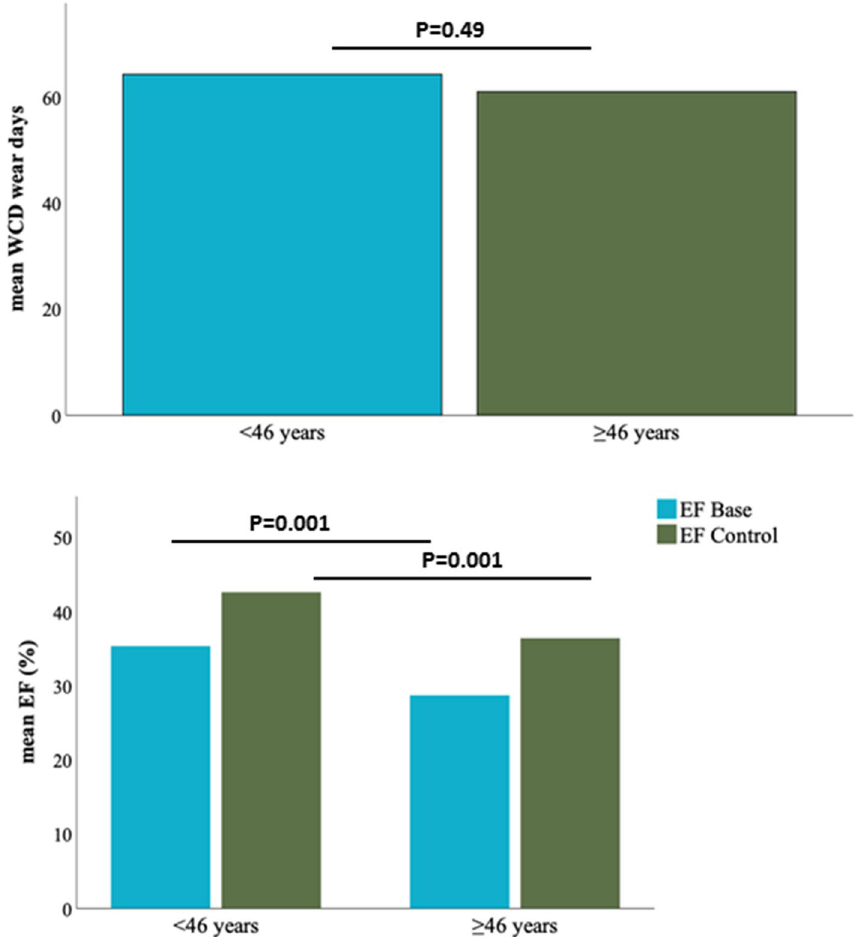
Figure 3. The comparison of WCD use according to age.